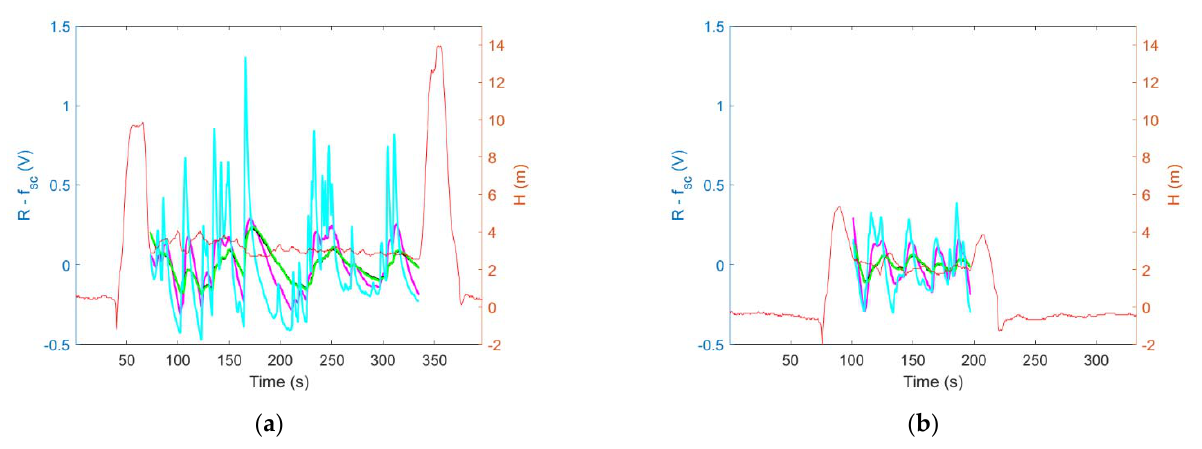
Figure 16. The variation of gas sensor signals recorded during experiment CE1 when the sensing platform was: ( a ) lowered from the drone, ( b ) docked under the drone. Gas sensor signals without systematic components are shown using the following colors: GM102B (magenta), GM302B (black), GM502B (green), and GM702B (cyan). The red line indicates the sensing platform height above the ground.